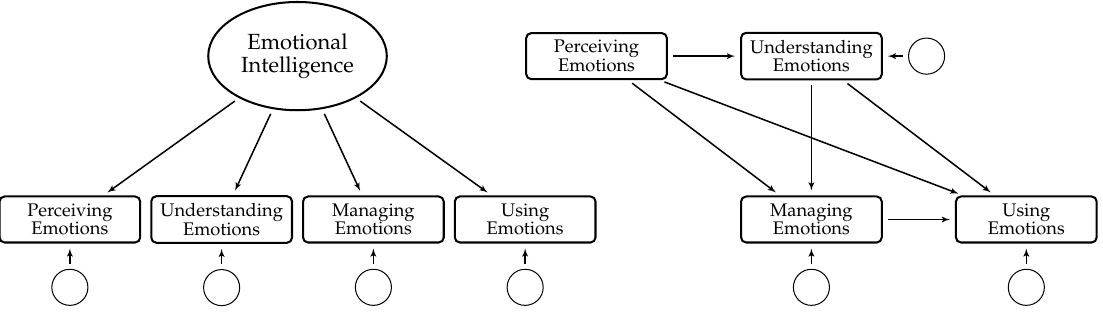
Figure 4. If the causal system model is an oversimplification, is not the latent variable model even more